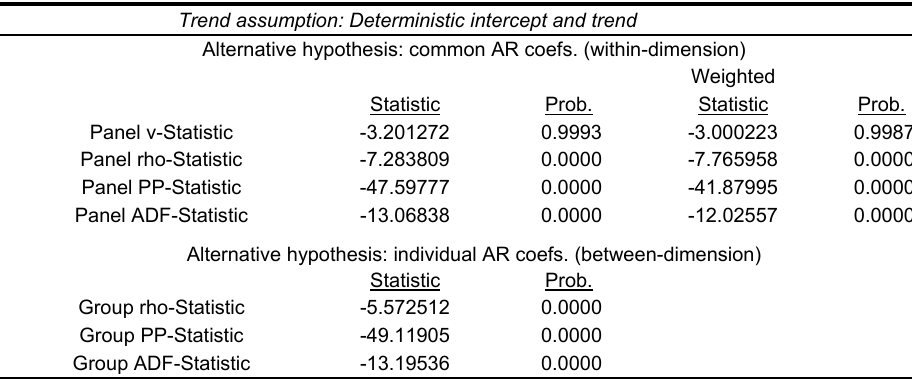
Table 6: Kao Residual Cointegration Test